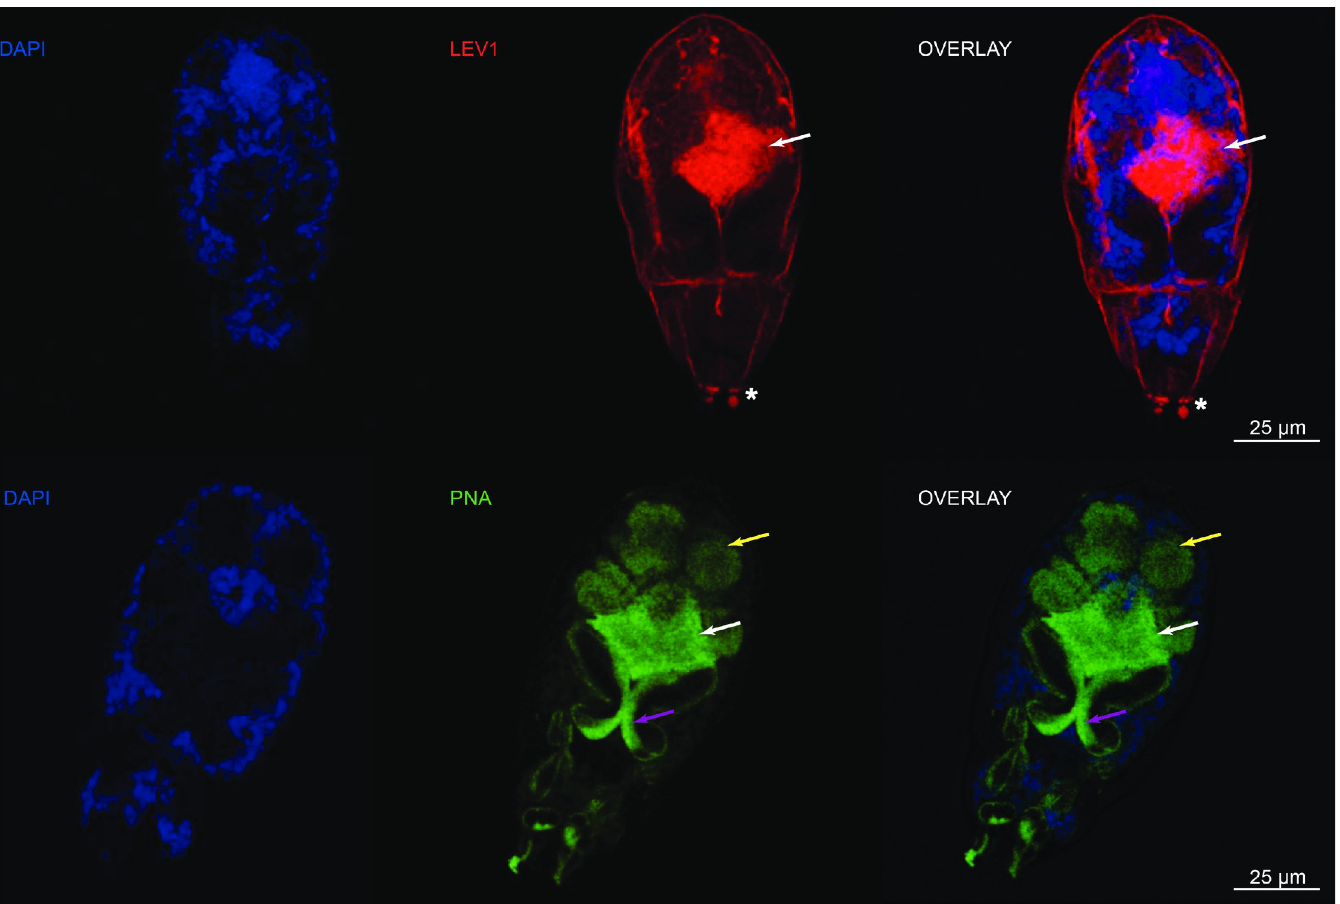
Fig 4. SmLEV1 is concentrated in cercarial pre-acetabular glands. (A) Permeabilised cercariae were stained with anti-SmLEV1.3 pAb (1:50) followed by goat anti-rabbit Alexa Fluor 594 secondary antibody (1,500). (B) Alternatively, permeabilised cercariae were stained with fluorescein labelled PNA (4 μ g/ml). Subsequently, all stained cercariae were stained with DAPI (1 μ g/ml) before mounting and visualisation. White arrows indicate the staining of the pre-acetabular gland with anti-SmLEV1.3 pAb (A) and PNA (B). Yellow arrows indicate post-acetabular glands and purple arrows indicate anterior acetabular ducts stained with PNA. Asterisk indicates staining of peripheral extensions also stained by rabbit pre-bleeds (S5